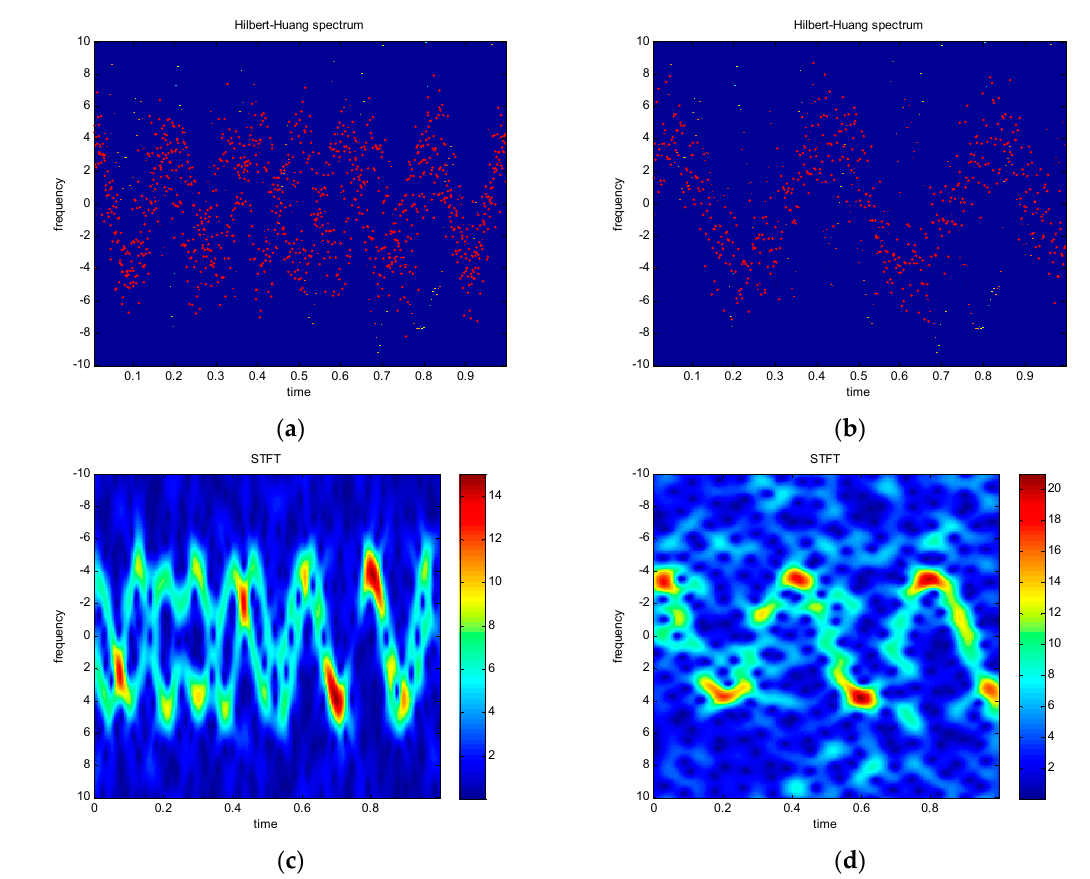
Figure 5. Decomposition results of HHT (Hilbert–Huang transform): ( a , b ) HH (Hilbert–Huang) spectrum of IMF1 (intrinsic mode function 1) and IMF2; ( c , d ) TFD (time-frequency distribution) of IMF1 and IMF2.